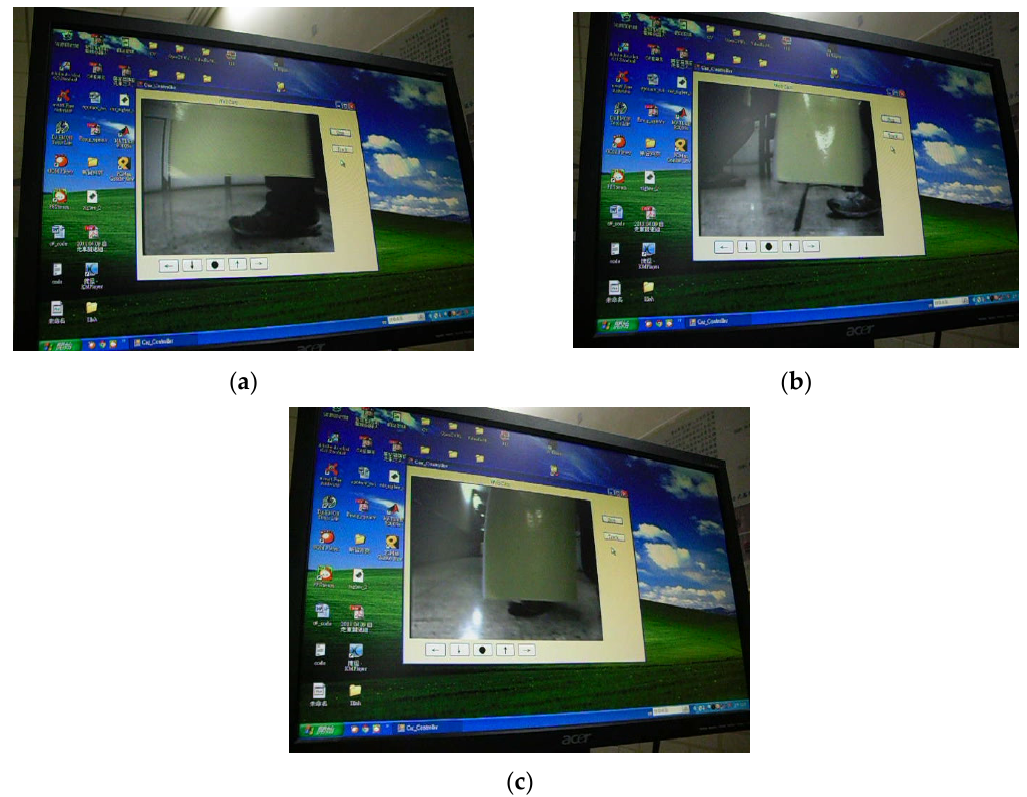
Figure 24. Images on the PC screen that are captured by the robot’s camera. ( a ) Captured image at Figure 23a position; ( b ) Captured image at Figure 23b position; ( c ) Captured image at Figure 23c position.